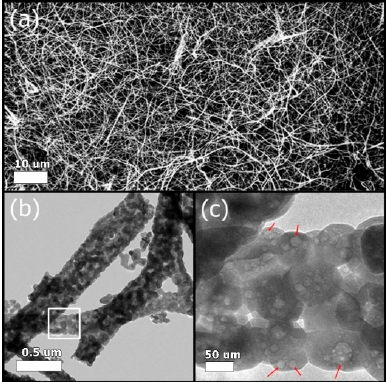
Figure 1. ( a ) SEM and ( b ) TEM images of the SrHANFs. ( c ) An enlarged graph in the white square of ( b ). The red arrows in ( c ) indicate mesopores within the nanocrystals.